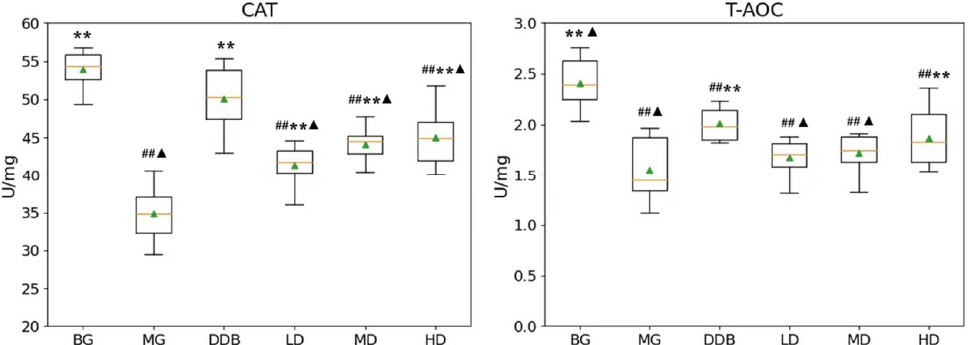
Figure 2. Effects of SBS on CAT and T-AOC in liver tissue. Data are presented as mean ± S.E.M. ( n = 10). Significant differences compared with the BG group were designated as ## p < 0.05, with the MG group as ** p < 0.01, and with the DDB groups as ▲ p < 0.05.